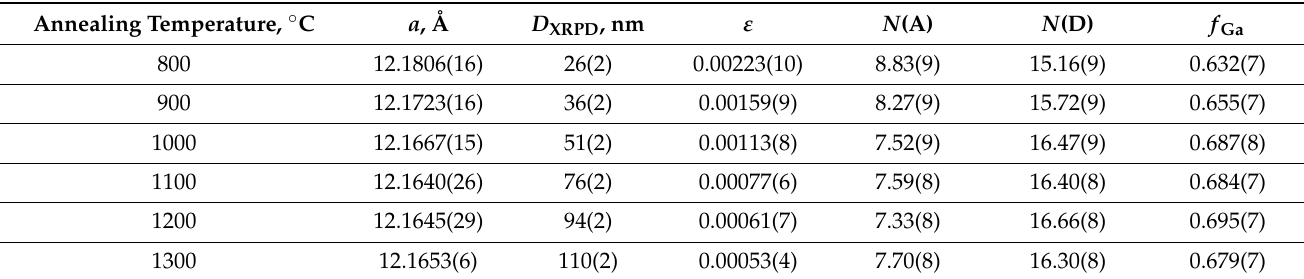
Table 1. Cell parameter a , crystallite size D XRPD , lattice microstrain ε , an average number of Ga 3+ ions per lattice in octahedral site N (A) and tetrahedral site N (D), and fractional parameter f Ga obtained by applying the Rietveld method to the XRPD patterns.